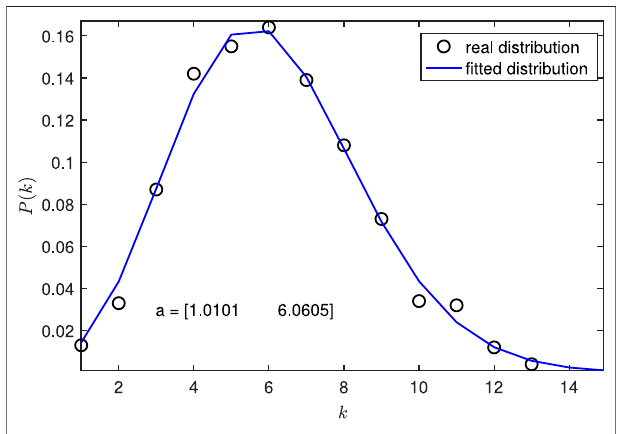
FIGURE 5 | Degree distribution of a randomly generated Erd ő s – Rényi network( n (cid:2) 1000, d (cid:2) 6). The function P ( k ) (cid:2) a 1 e − a 2 a k 2